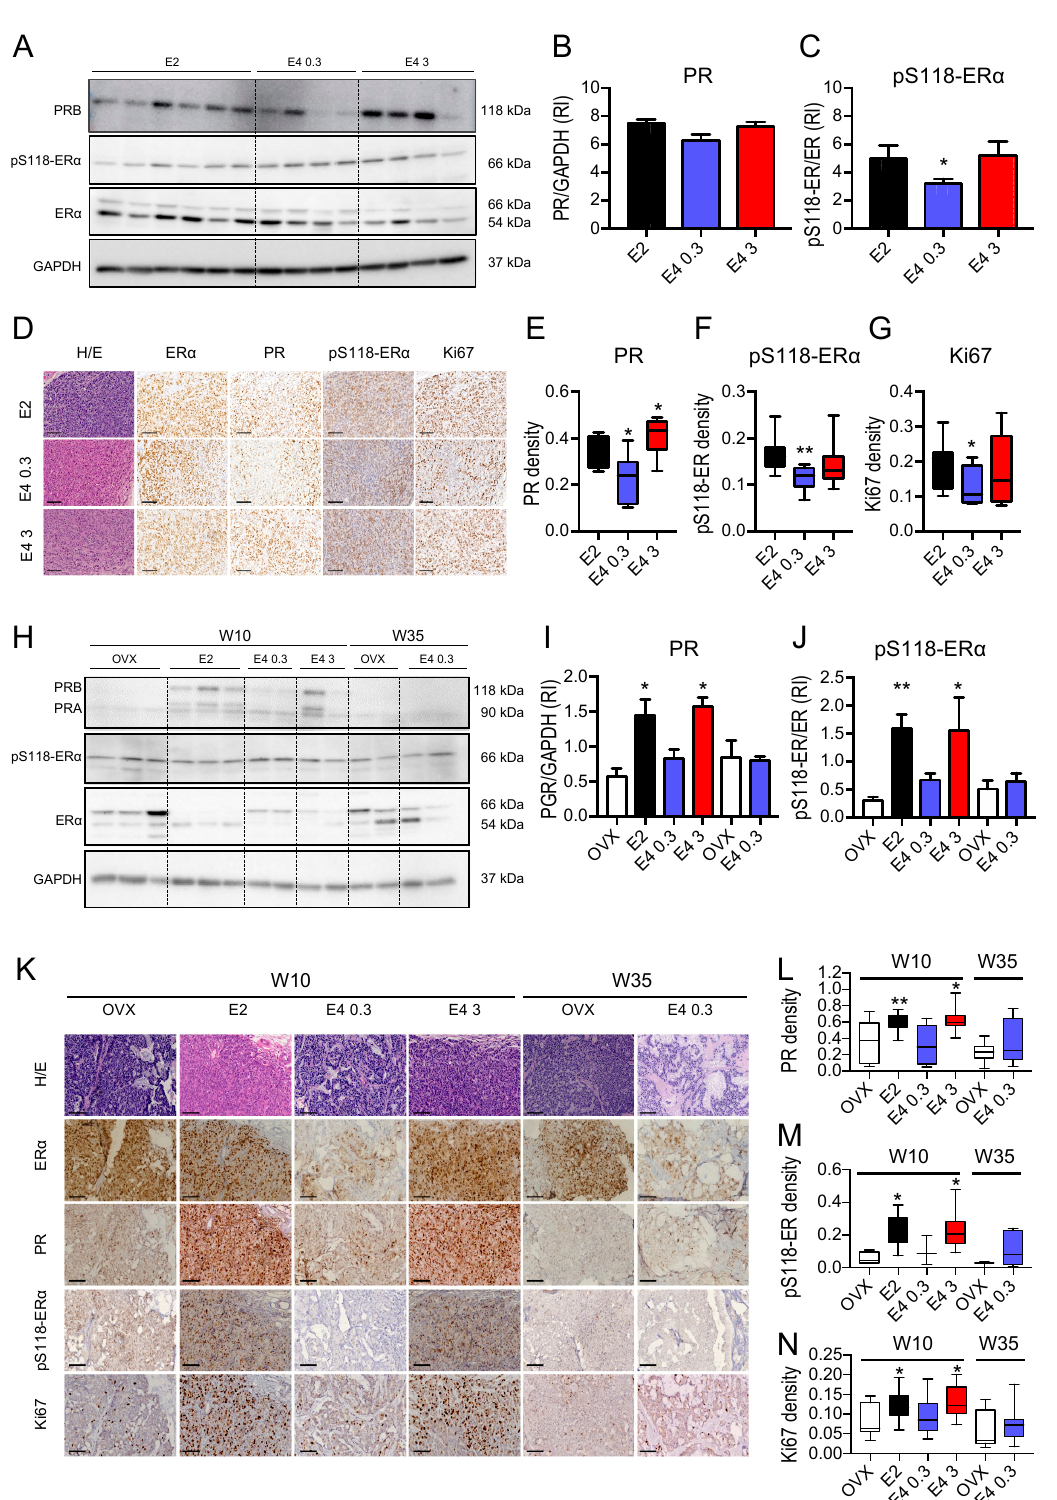
Figure 5. E4 is less potent than E2 to promote ER α signaling in vivo. ( A ) Representative Western Blot of PRB, pS118-ER α and ER α from MCF7 tumors harvested from mice treated with E2 (0.08 mg/kg/day) or E4 (0.3 or 3 mg/kg/day). GAPDH was used as a loading control. ( B ) Quantification of PR expression normalized to GAPDH level and ( C ) quantification of pS118-ER α protein level normalized to ER α . RI= Relative Intensity. ( D ) Representative immunostainings of ER α , PR, pS118-ER α and Ki67 on MCF7 tumors harvested from mice treated with E2 (0.08 mg/kg/day) or E4 (0.3 or 3